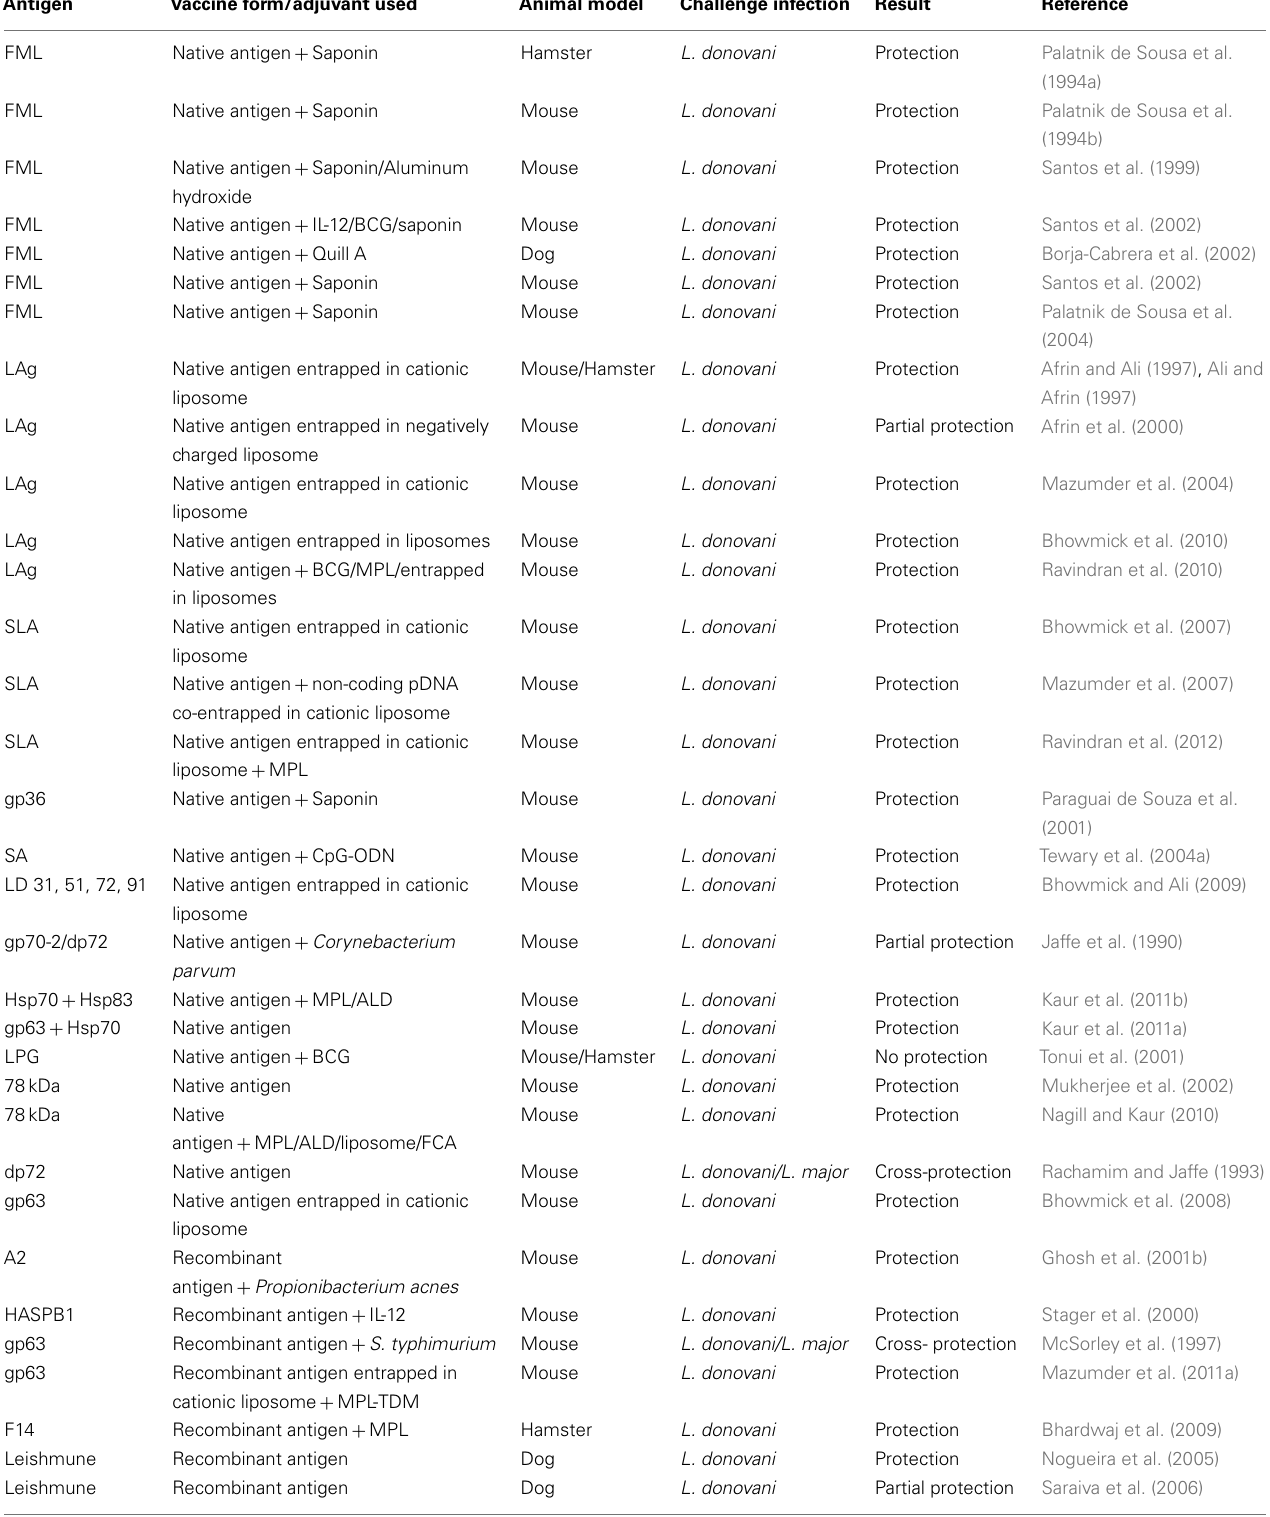
Table 1 | Second-generation vaccine candidates tested against L. donovani .